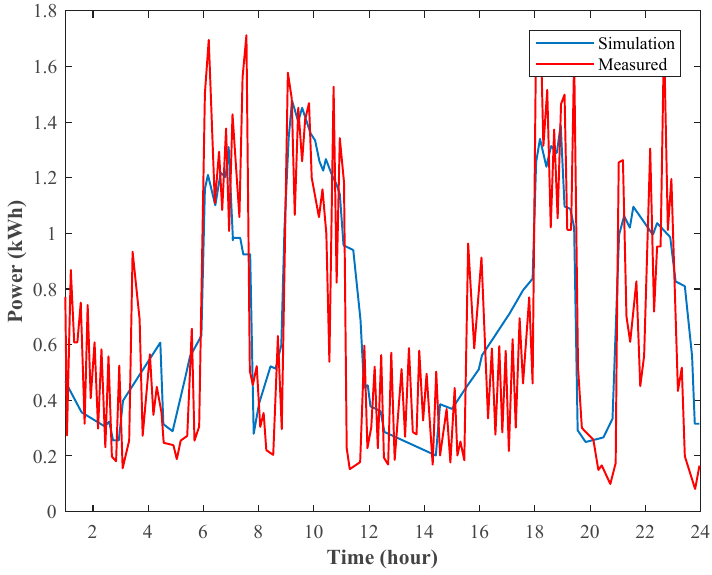
Figure 3. Simulated and measured hourly electricity usage of building 1.